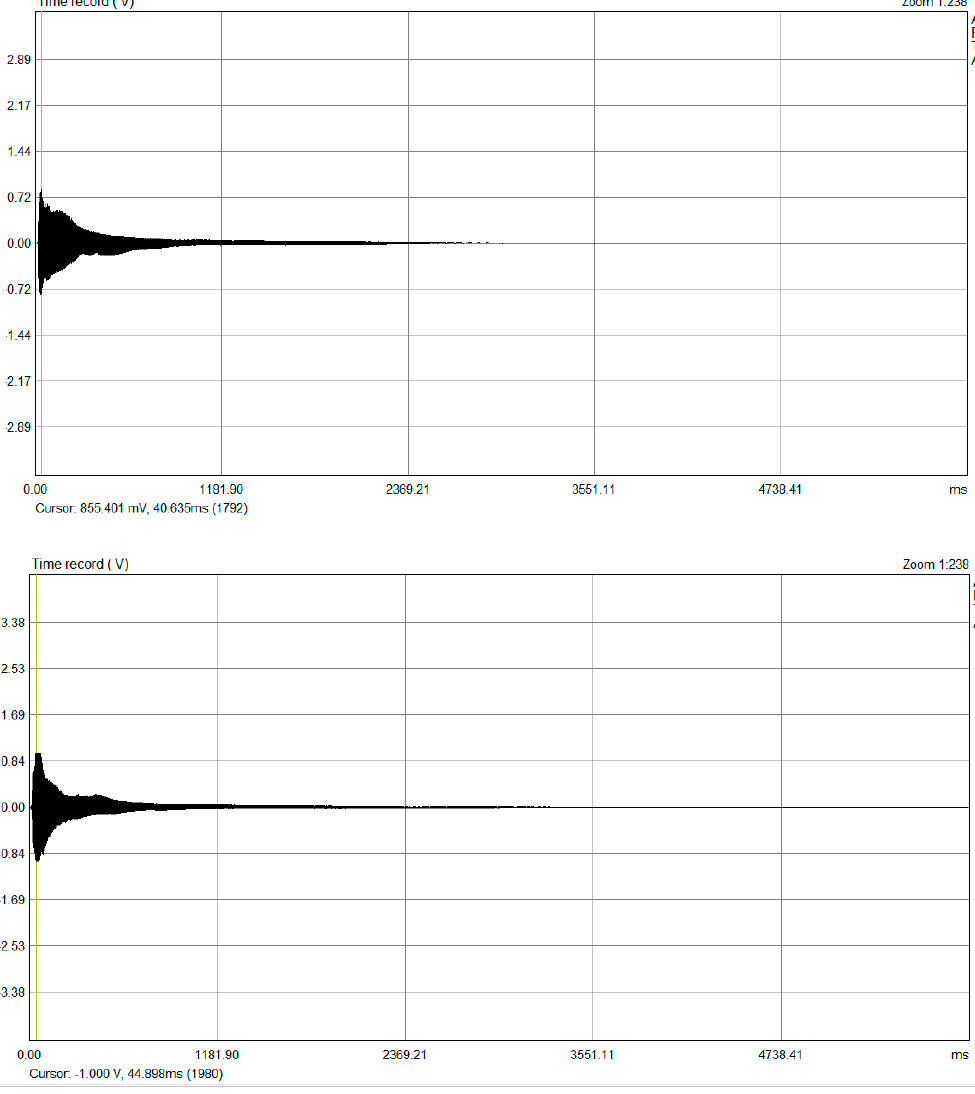
Figure 14. Time record history of the Delroba (top), Eshghi (middle), and Mahava (bottom). Table 1. Time response results.